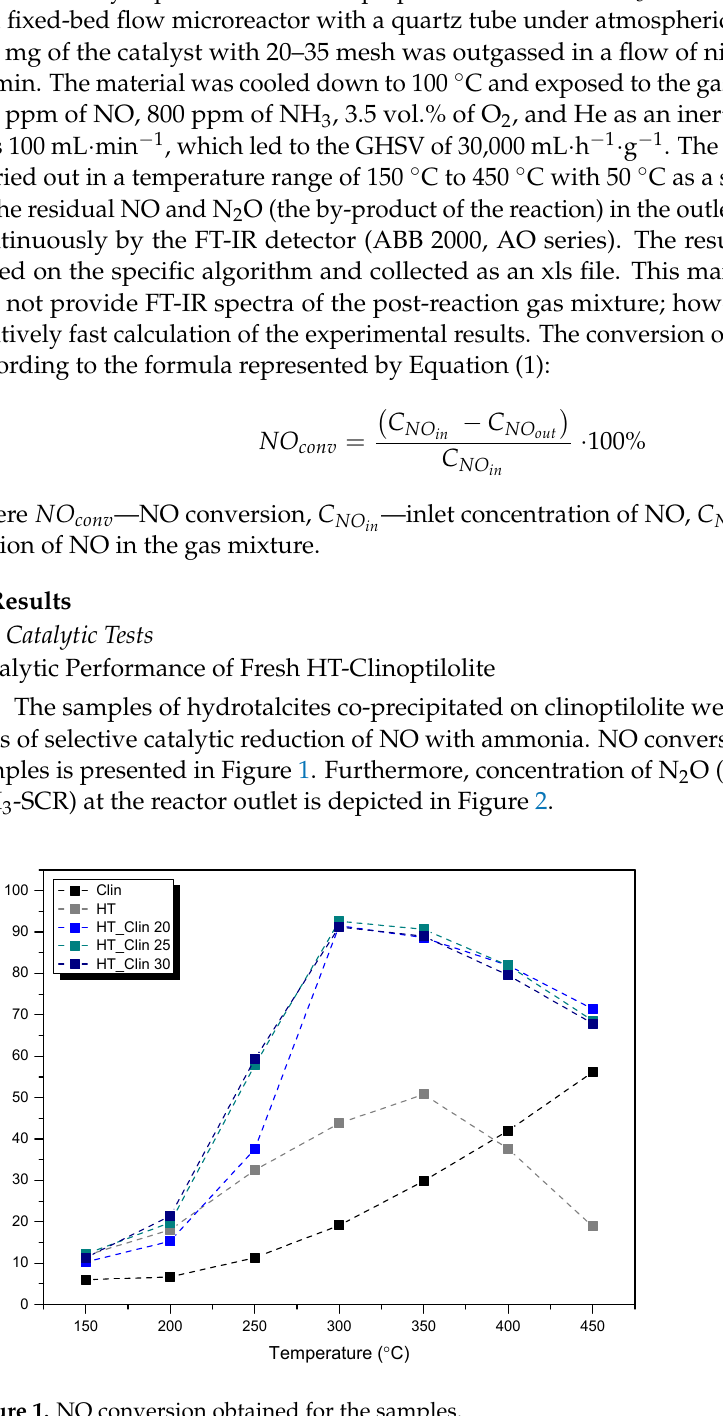
Figure 1. NO conversion obtained for the samples.